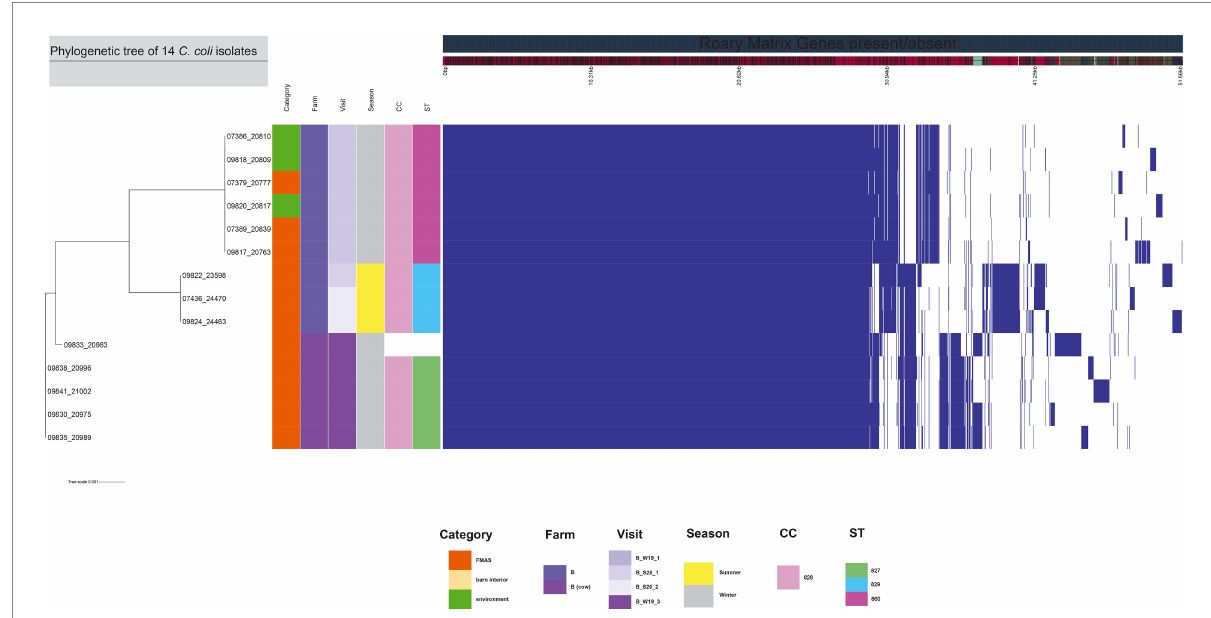
FIGURE 3 The figure was drawn using the phandango.net web application (Hadfield et al., 2017). The left panel shows the maximum likelihood tree of 14 C. coli isolates (1,482 genes) based on the alignment of core-genome calculated with RAxML. The top panel shows a single representative nucleotide sequence (0 bp-51.56 kb); contigs (fragments are colored by similarity) and genes are derived from the pan-genome content. The right panel displays the Roary pangenome sorted from core genes on the left to accessory genes to the right, with presence (blue) or absence (white) of blocks relative to genes and contigs in the pan-genome. The middle features metadata [category, farm, visit, season, clonal complex (CC), and sequence type (ST)]. White blocks represent unassigned CCs and